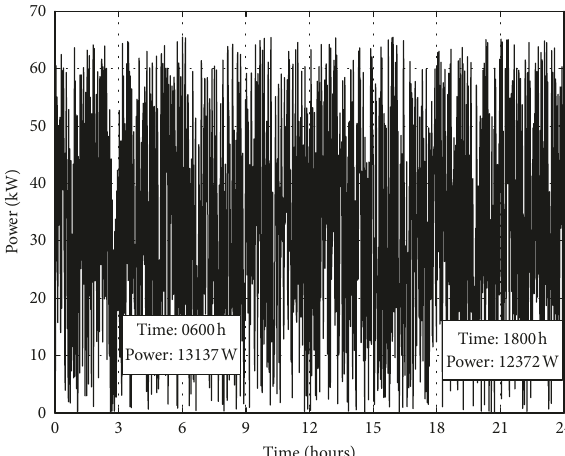
Figure 3: Encryption with RC4 using Key1 .